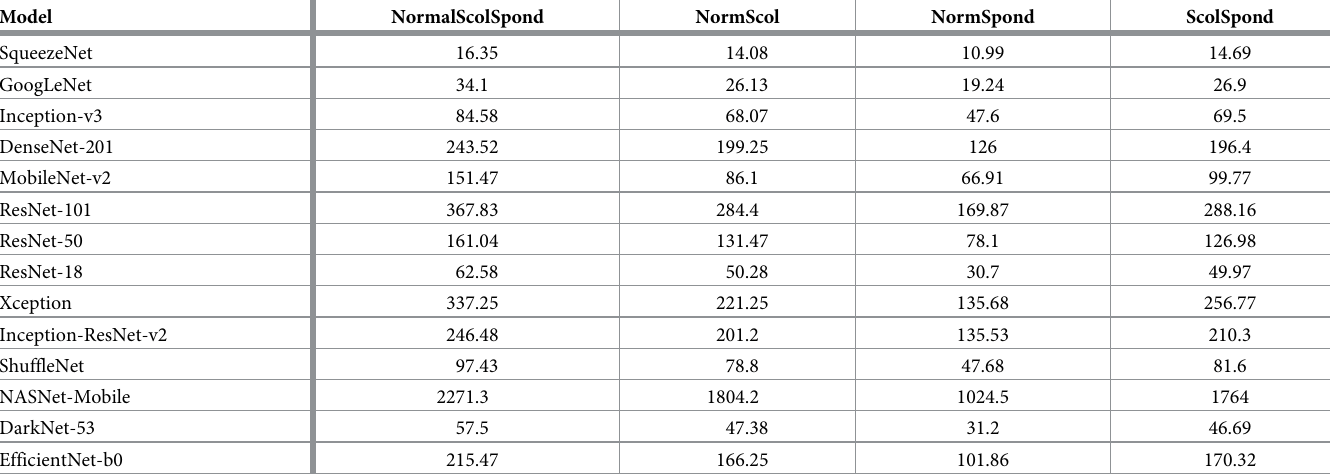
Table 9. The mean training and validation time for classifying X-ray images for each deep learning model. All times are in